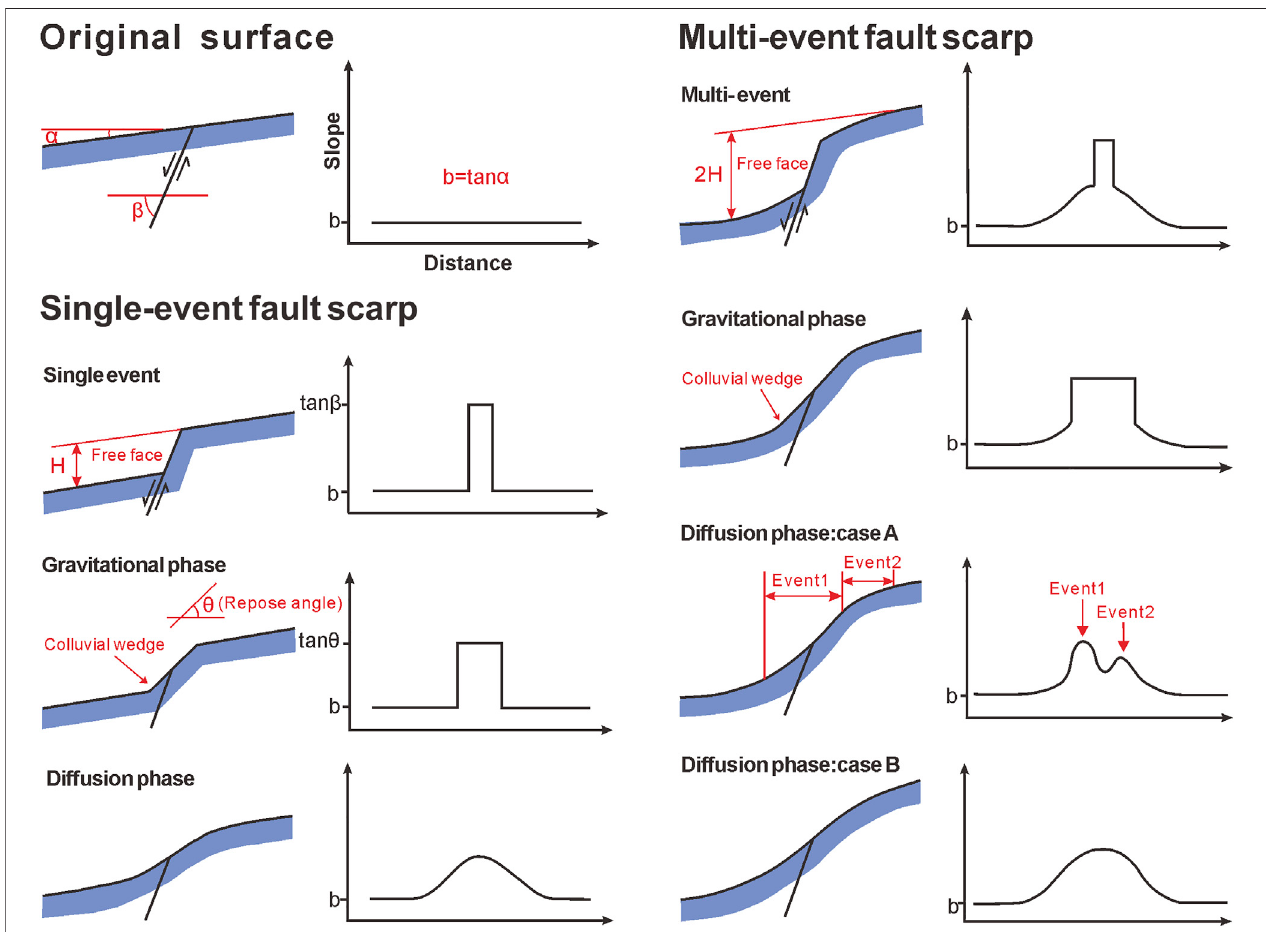
FIGURE 3 | Morphological characteristics and evolutionary processes of single-event fault scarp and multi-event fault scarp (modi fi ed from Avouac and Peltzer, 1993; Rao et al., 2020).